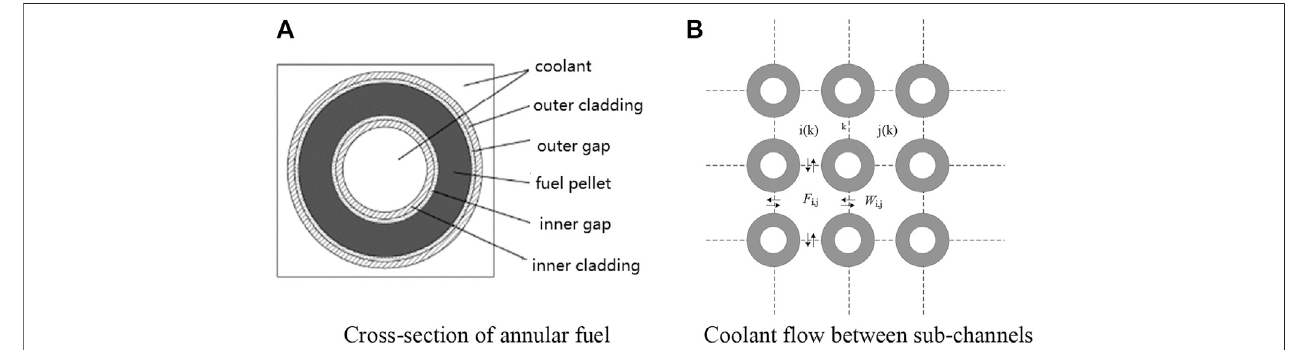
FIGURE 1 | Schematic diagram of annular fuel and coolant fl ow relationship between sub-channels.